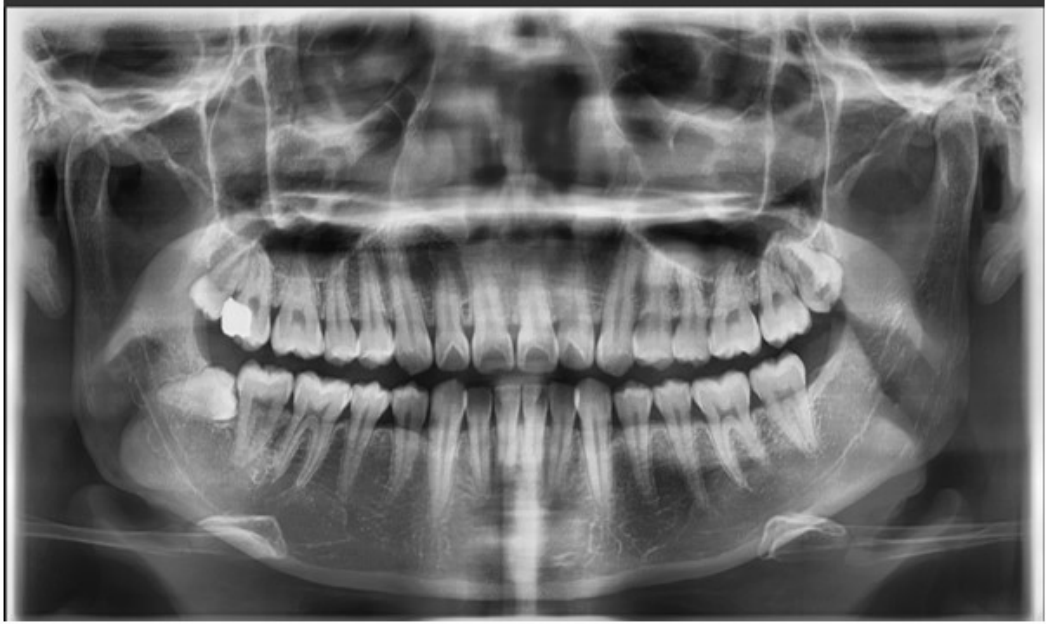
Fig. 4b - Panoramic radiograph - no radiological signs of radix entomolaris and C - shaped configura�on of root canals in the mandibular